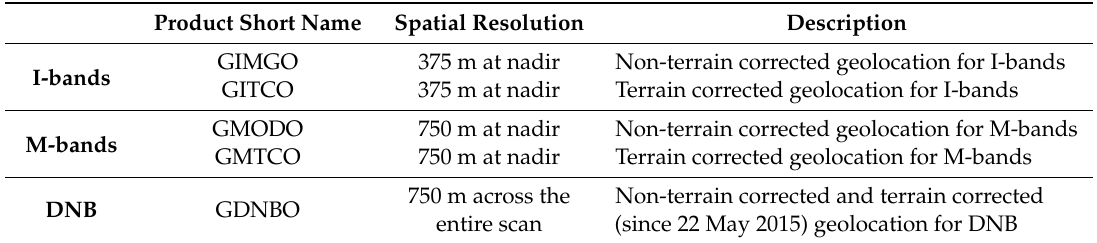
Table 1. Summary of the Visible and Infrared Imaging Radiometer Suite (VIIRS) geolocation products.